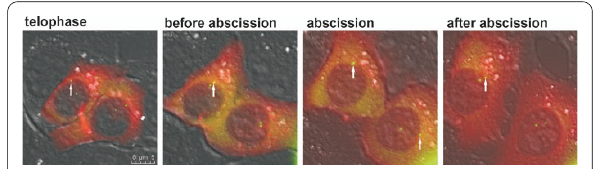
Figure 4 Centriole movement in mouse mammary epithelial cells during cytokinesis . During cytokinesis, centrioles show increased mobility and either one centriole or the complete centrosome is fre- quently associated with the nuclear envelope. After abscission centri- oles increase their mobility and frequently detach from the nuclear envelope. The images show an overlay of DIC, green and red record- ings to show centriole-specific centrin1-EGFP localization together with the intercellular bridge marker α-Tubulin-mCherry. White arrows indicate centrioles by the nuclear